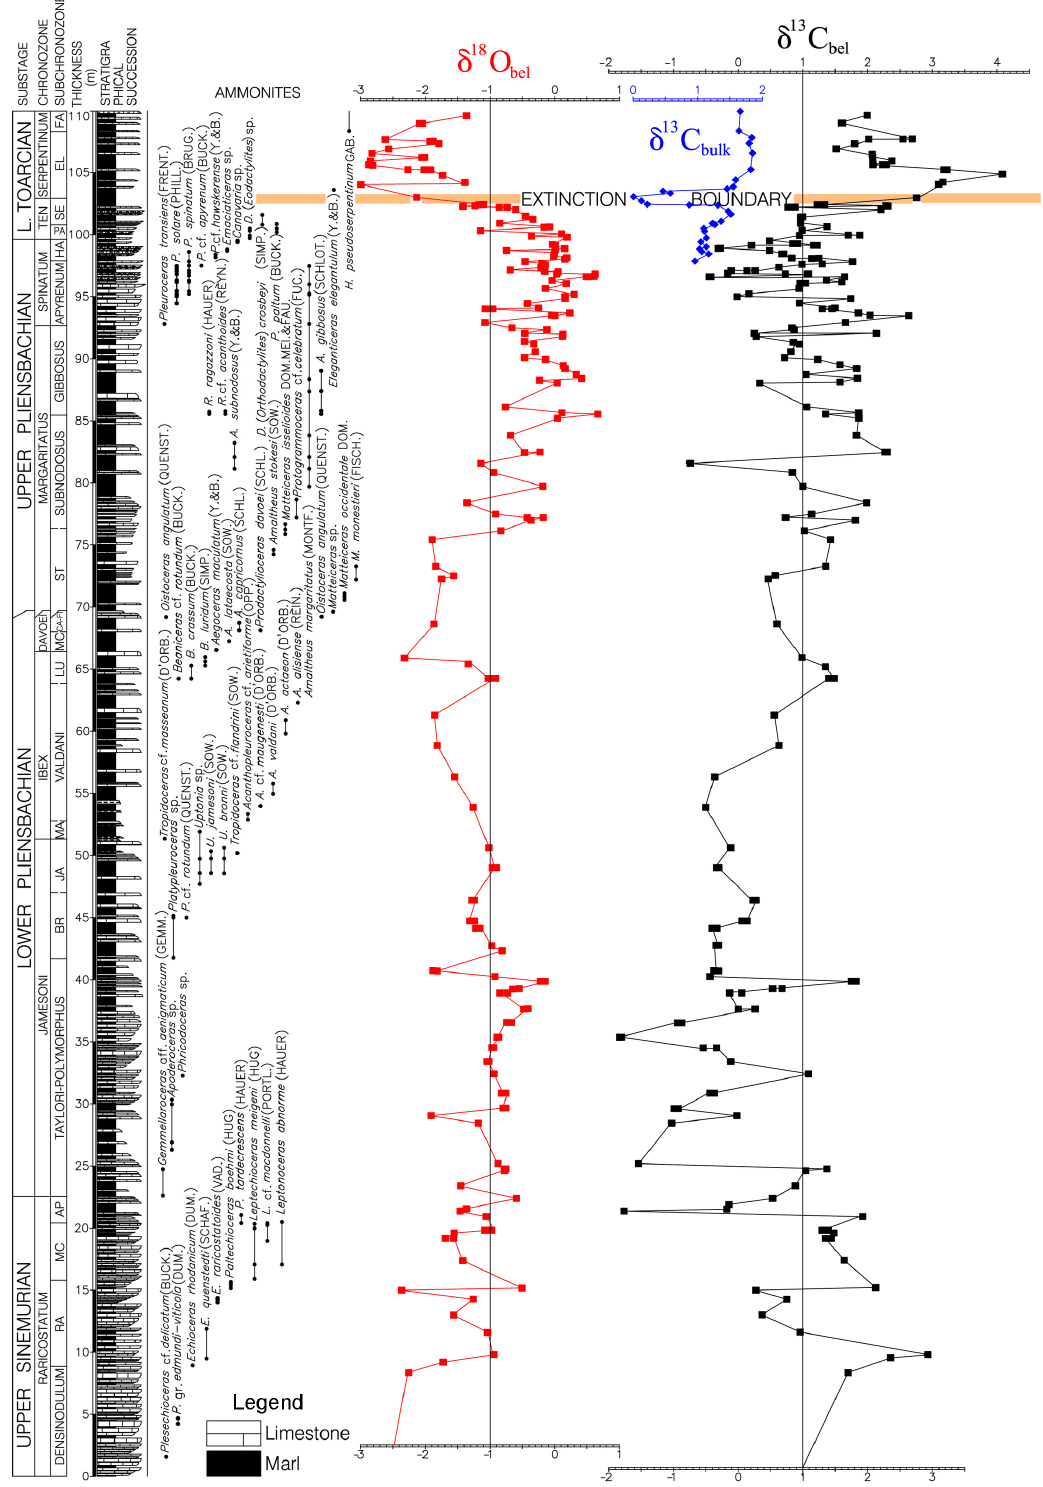
Figure 3. Stratigraphical succession of the Upper Sinemurian, the Pliensbachian and the Lower Toarcian deposits of the Rodiles section, showing the lithological succession, the ammonite taxa distribution, as well as the profiles of the δ 18 O bel and δ 13 C bel values obtained from belemnite calcite. δ 18 O bel and δ 13 C bel in PDB. Chronozones abbreviations: TEN: Tenuicostatum. Subchronozones abbreviations: